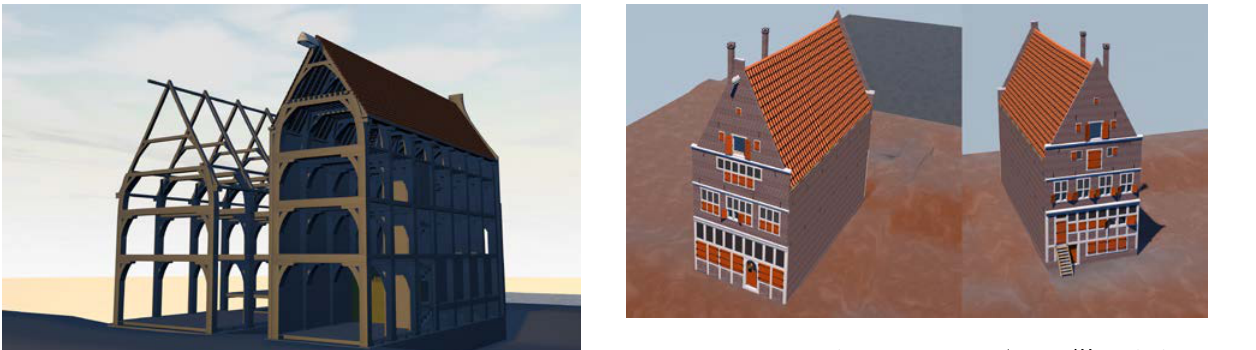
Figure 4. The house of Pompeius Occo, ‘t Paradijs . Left: front side. Right: back side (image by L. Figure 3. Reconstruction of the timber frame (image by L. Opgenhaffen)